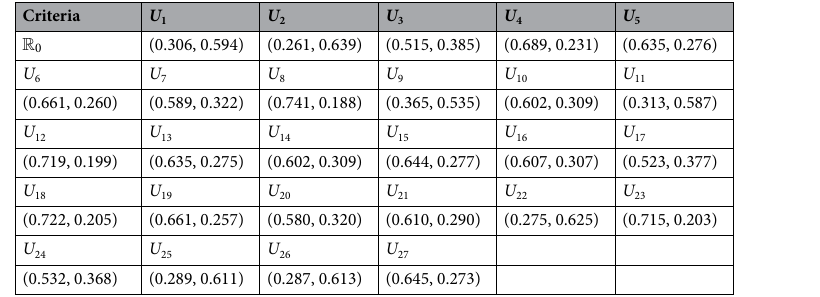
Table 11. The OPR of sustainable industrial building